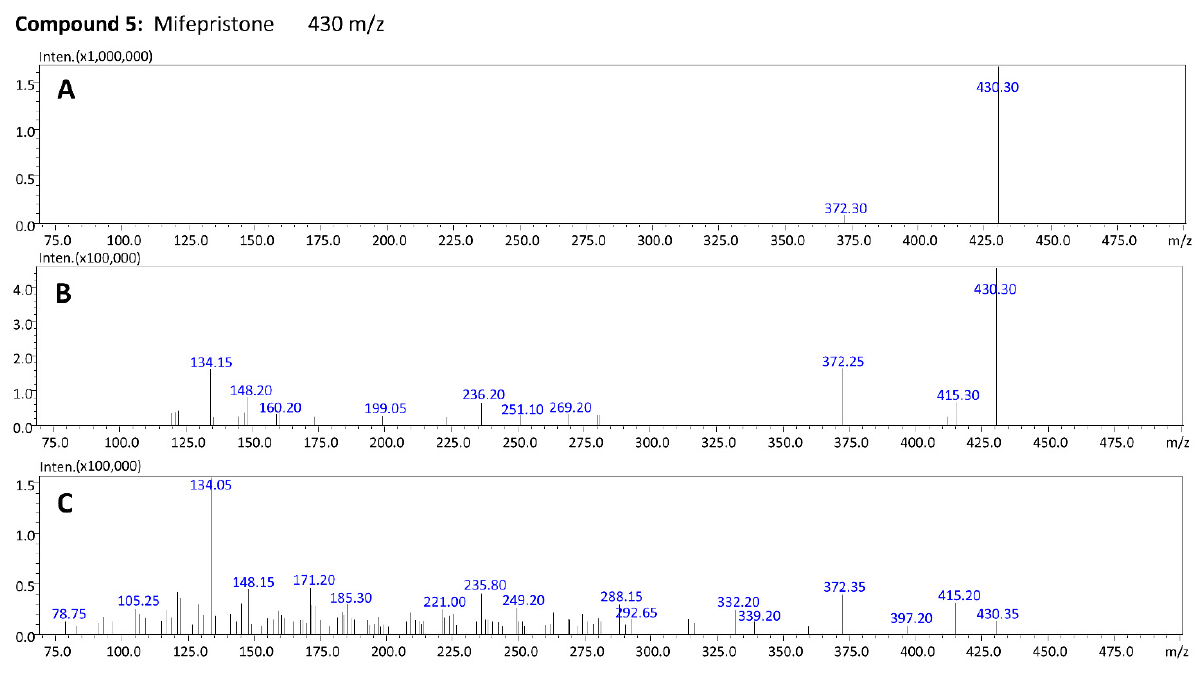
Figure 5. Product ion spectra for mifepristone (precursor ion: 430 m / z ) at three collision energies ( A ) − 10 V; ( B ) − 20 V and ( C ) − 35 V.